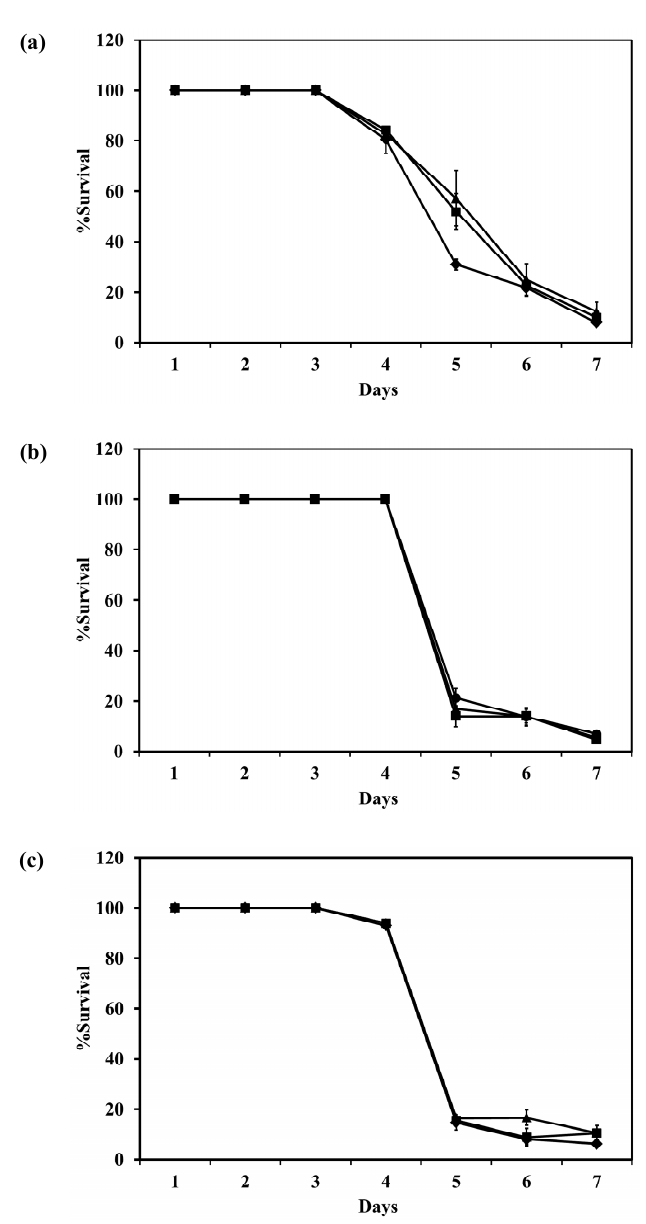
Figure 10. The reduction of intracellular M. bovis (% survival) in macrophage cells after incubation with ( a ) LEV; ( b ) LEV-proliposome formulation No. 1; ( c ) LEV-proliposome formulation No. 5 at different concentrations ( ● ) 5; ( ▲ ) 10; ( ■ ) 20; ( ♦ ) 40 µg/mL (Mean ± SD, n ≥ 3).